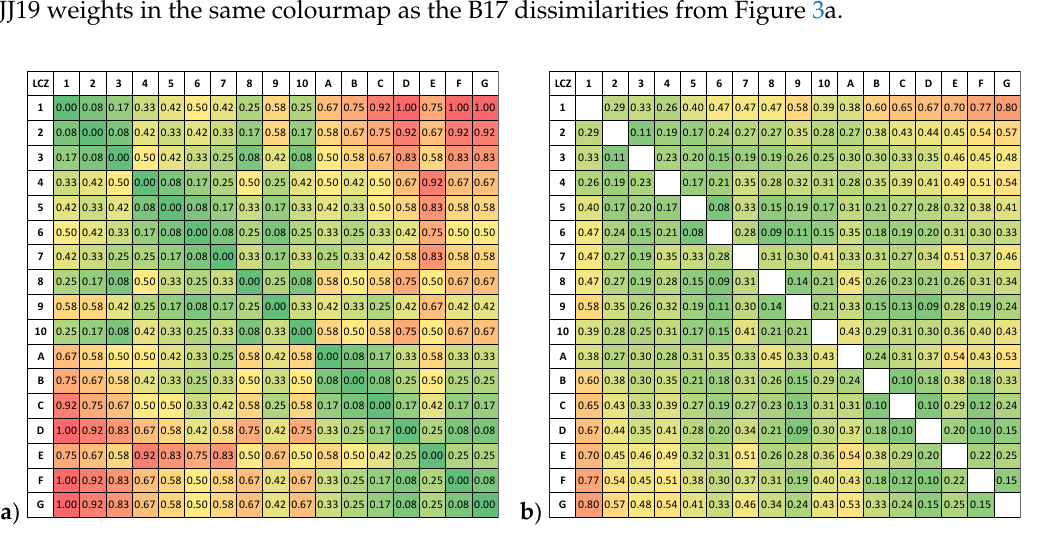
c ) Figure 4. ( a ) Example of three-class confusion matrix ; ( b ) metric implicitly used by the overall